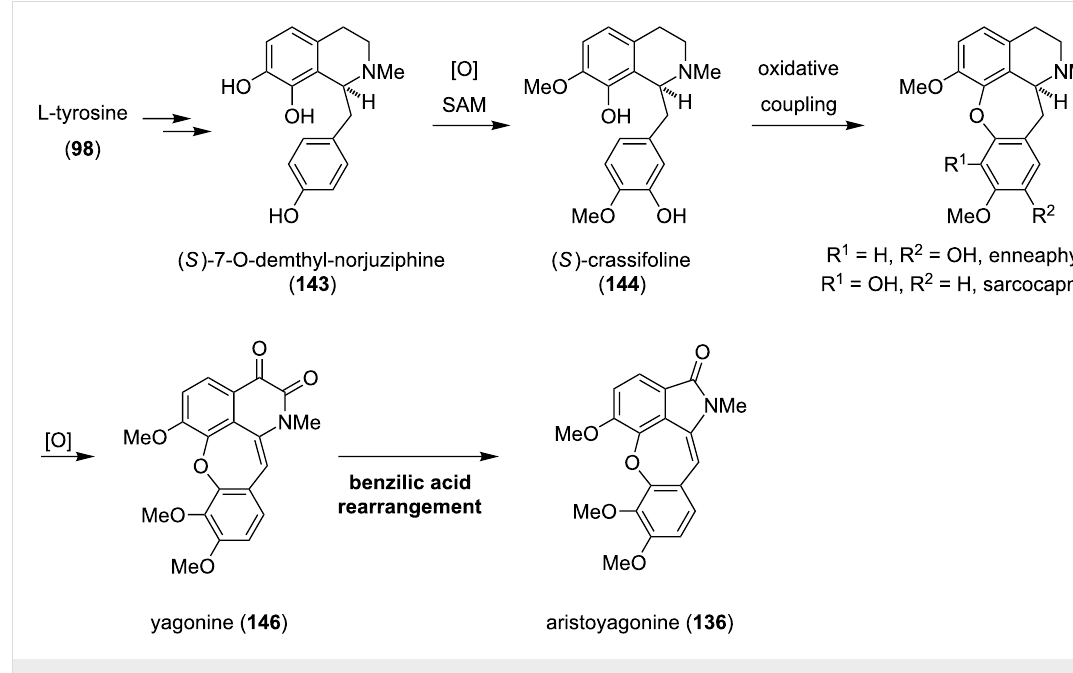
Scheme 18: Proposed biosynthesis of 136